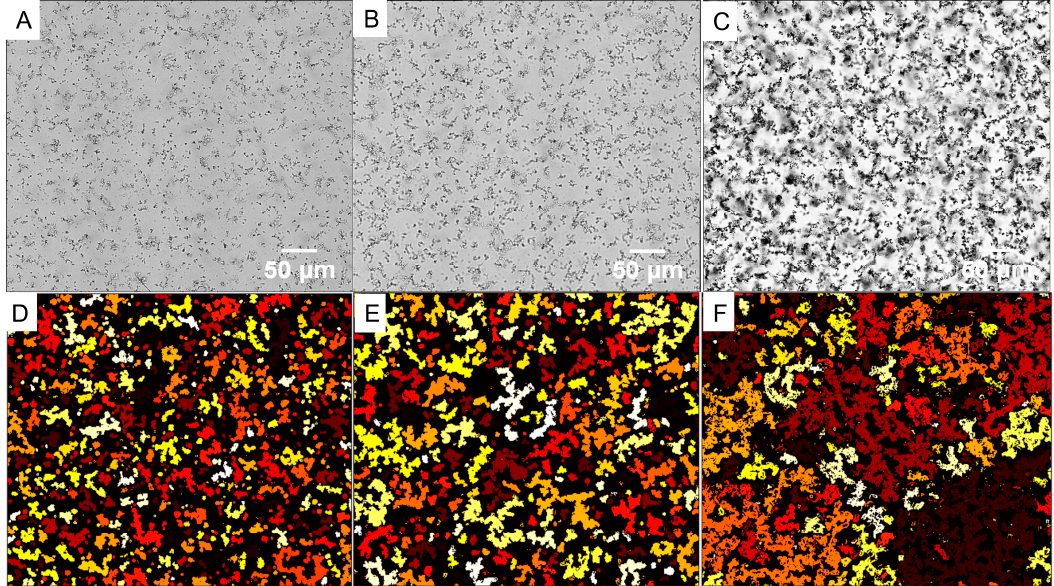
Figure 1. Large-stitched images of asphaltene aggregates at the end of each experiment. A , B , and C represent bright-field images of aggregates formed by adding 52 vol%, 55 vol%, and 57 vol% heptane to model oil, respectively. D , E , and F represent the corresponding binary images after applying Ostwald’s global thresholding criterion. The scale bar is 50 μ m.